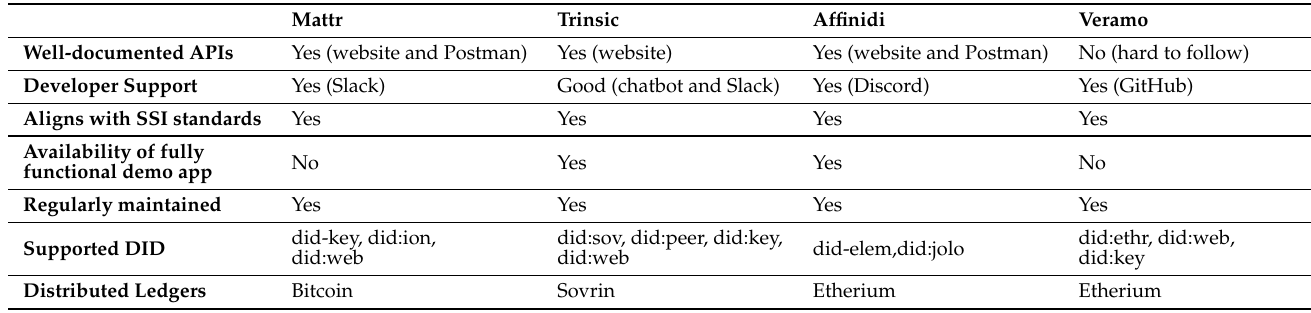
Table 2. Comparison of different SSI